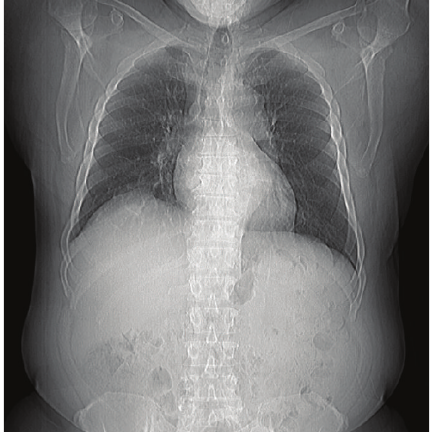
Figure 3: Admission CT scan did not show pulmonary